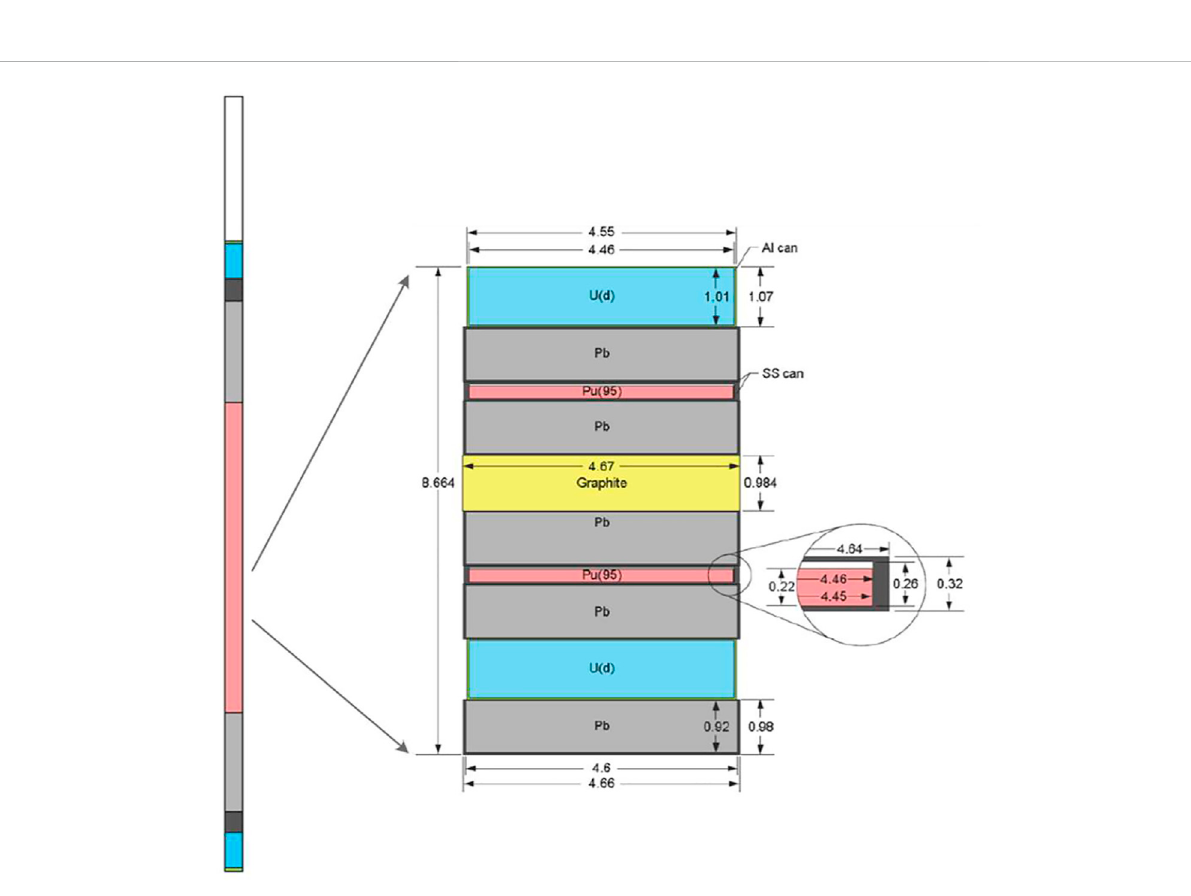
FIGURE 6 Layout of the fuel